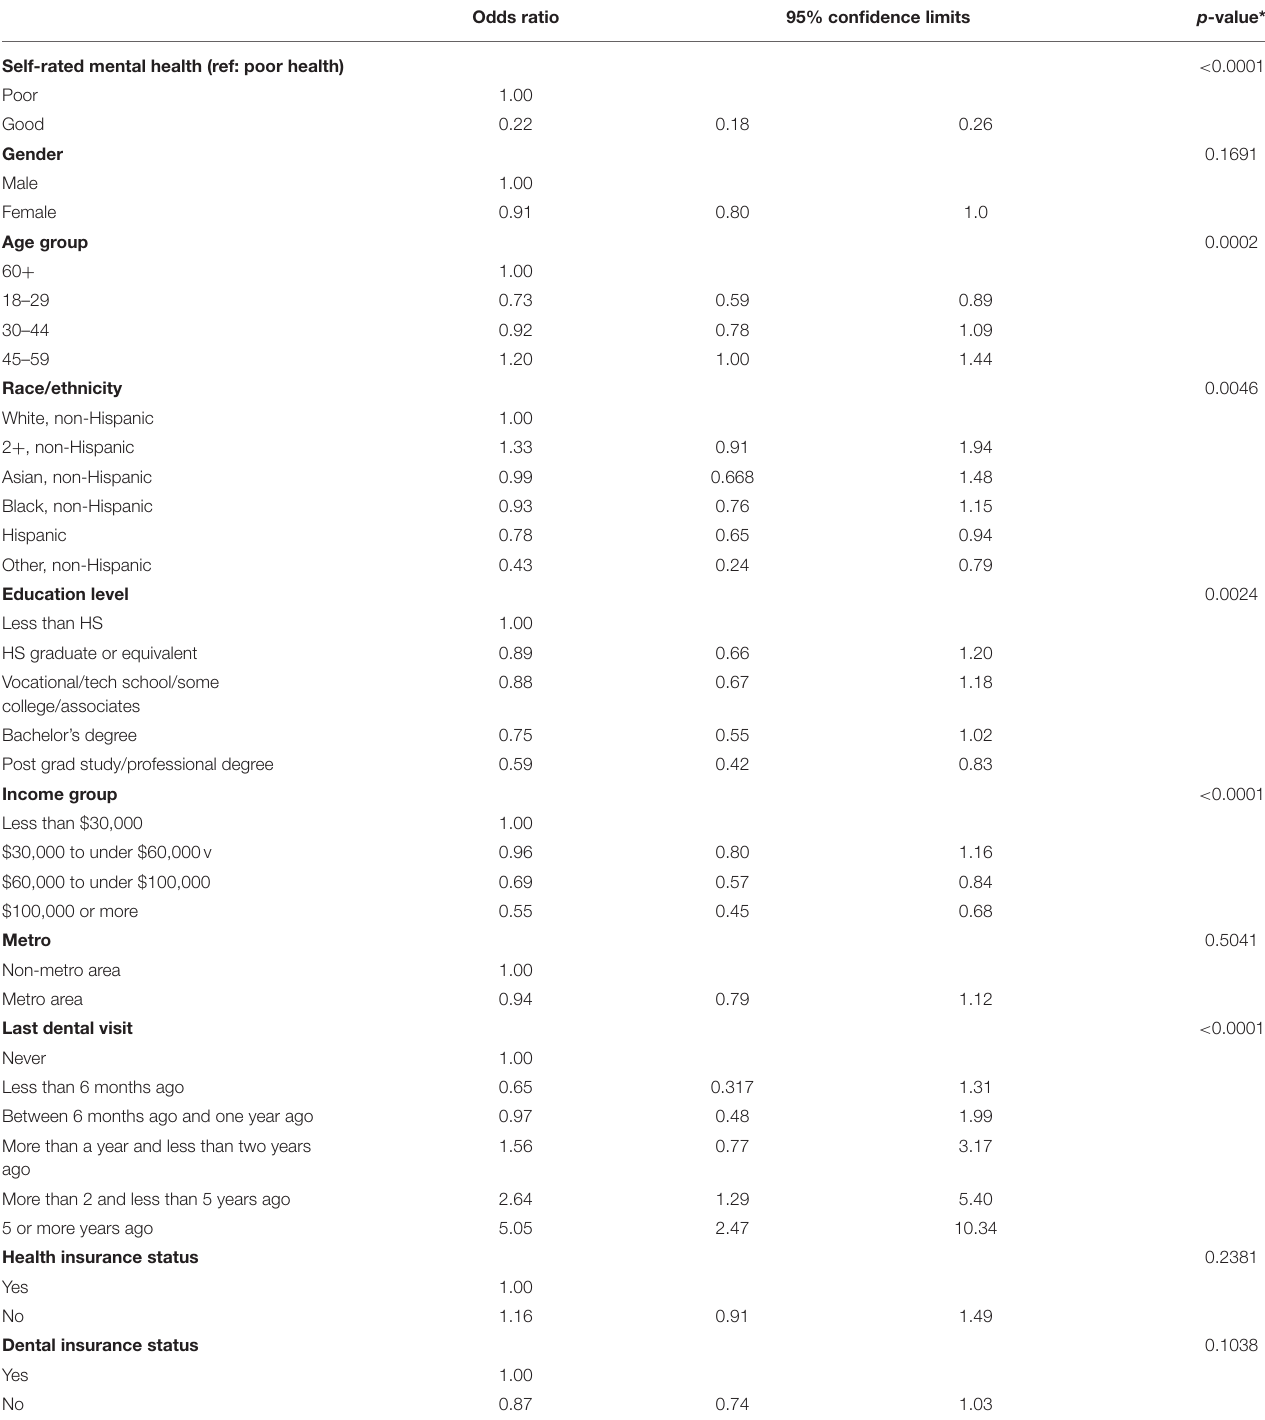
TABLE 2 | Association between Oral Health Status and Mental Health from the State of Oral Health Equity in America survey 2021. Odds ratio 95% confidence